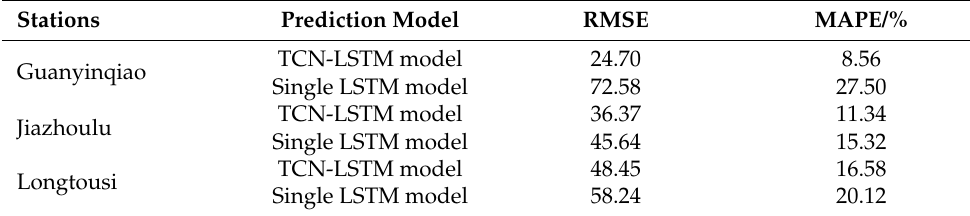
Table 4. Comparison evaluation results of model